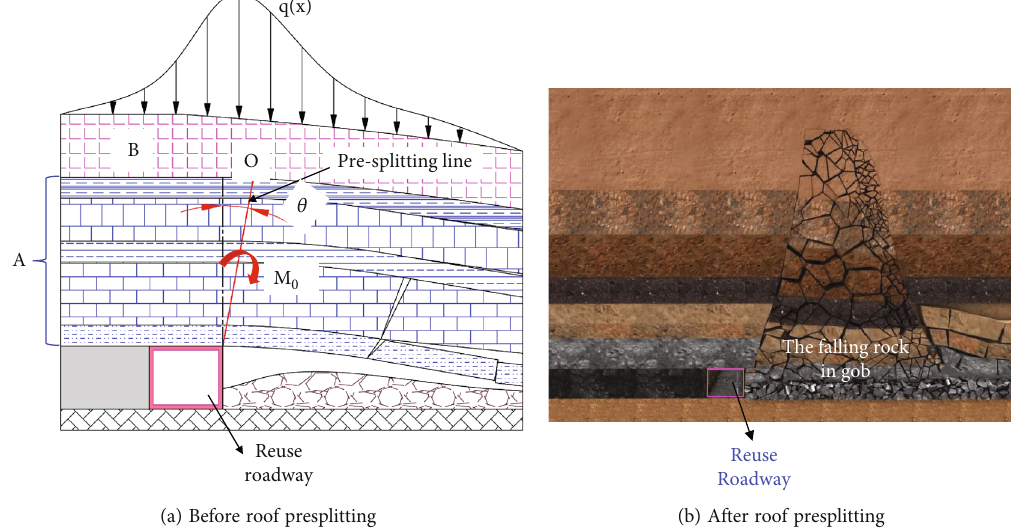
Figure 3: Mechanical model of the presplitting structure of compound soft rock